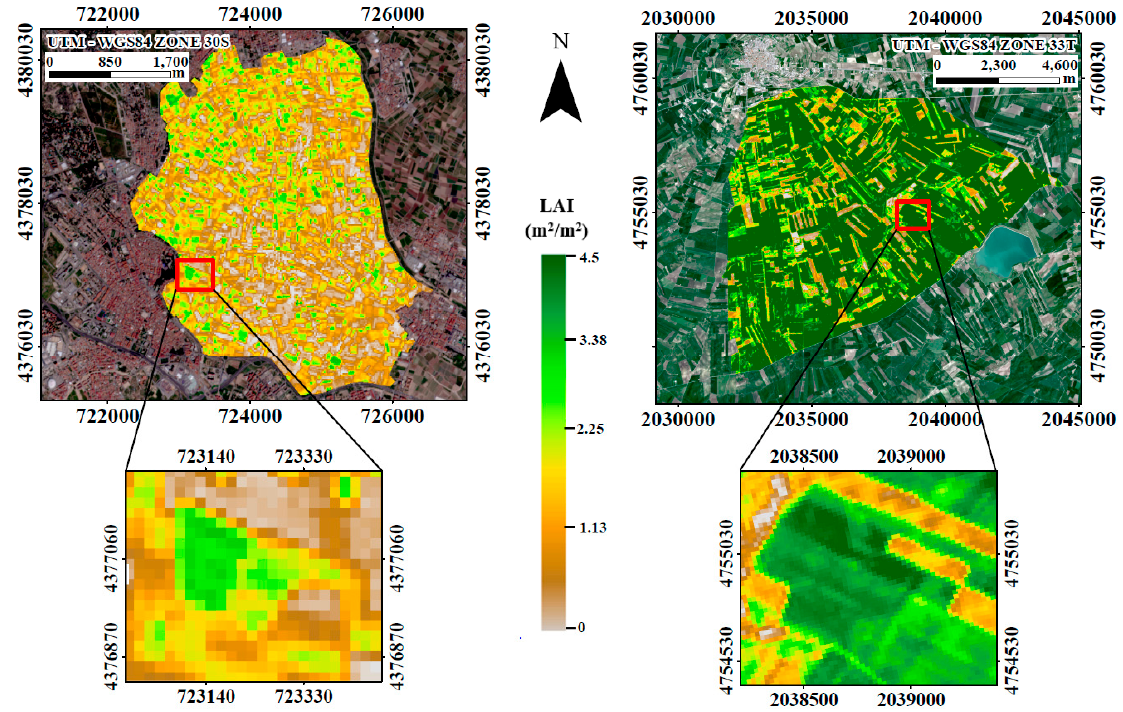
Figure 8. LAI green maps estimated with SeLI proposed index in Valencia test site using the Sentinel-2 image of 26 May 2017 (left) and Foggia test site using the Sentinel-2 image of 8 April 2017 (right). Note the different scale of both study sites and their respective agricultural areas.